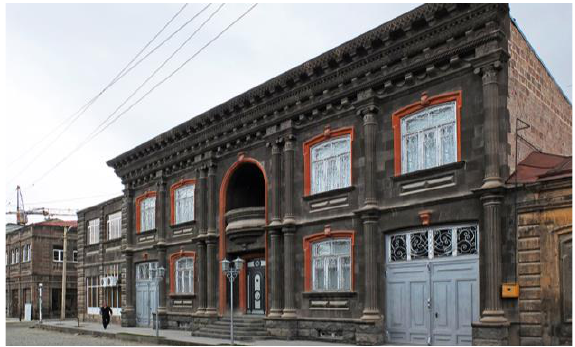
Figure 20. House on Abovyan Street, built in the 2000s – a “replica” of the “House with two cornices”. Photo by the author, 2017.